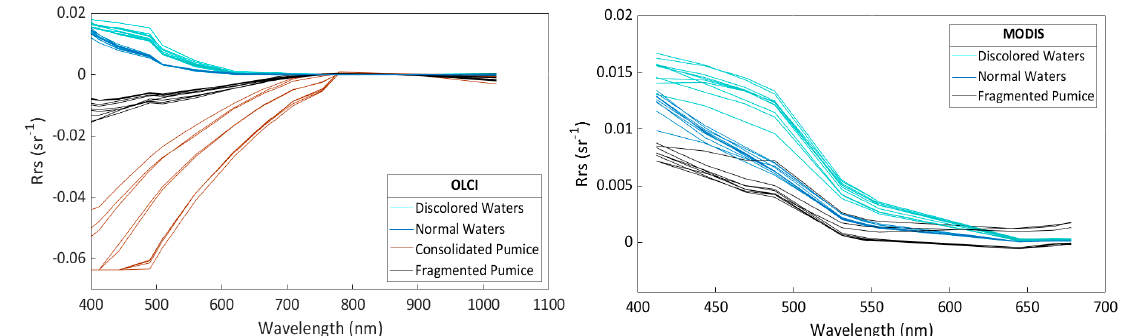
Figure 8. Spectra of Rrs pixels within surface pumice, discolored waters, and normal waters for (left) 9 August 2019 (21:33 UTC) using Sentinel-3A OLCI L2 Water Surface Reflectance at Full Resolution (WFR), and (right) 10 August 2019 (01:55 UTC) MODIS Aqua L2 data. Note that Rrs values were retrieved by dividing Oa3 reflectance (water-leaving radiance) values by π to make them comparable with MODIS values.